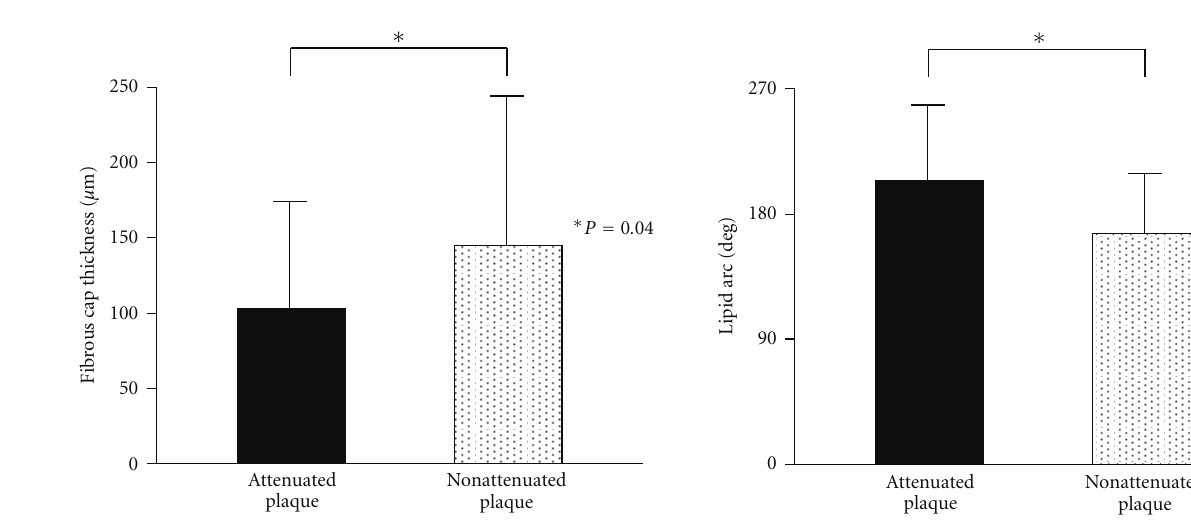
Figure 3: Comparison of lipid arc between attenuated plaques and nonattenuated plaques. In lipidic plaques, lipid arc as determined by OCT was significantly greater in IVUS-detected attenuated plaques compared with nonattenuated